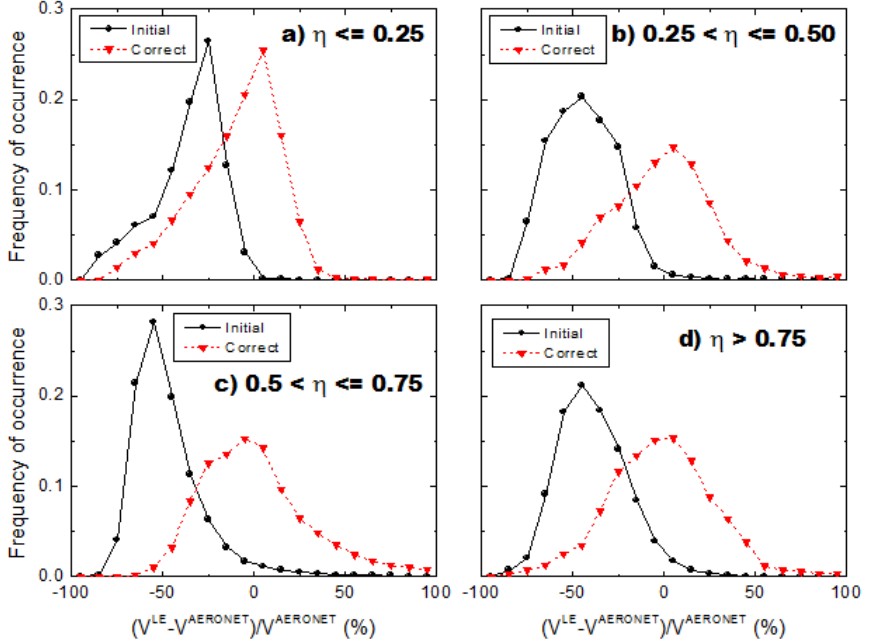
Figure 12. Frequency histograms of the relative differences of columnar volume aerosol content obtained by linear estimation ( V LE ) and those obtained by AERONET ( V AERONET ) . We used the database of ∼ 75000 intercomparisons combining all the sites of Table 2. Black lines correspond to data with no-correction while red lines are for data after applying correction functions. Table 4. For the period 20–30 July using sun and star photometry measurement at Granada (Spain), mean values of day- and night-time aerosol optical depth (AOD) at 440nm (436 for night-time), Angström exponent α computed between 440–870nm (436–870 for nighttime), fine mode fraction to aerosol optical depth ( η) , effective radius ( r eff ) and columnar volume aerosol content ( V ) . Also the air masses that reached the study area every day and night are presented. Backward trajectories of air masses were computed by HYSPLIT model at